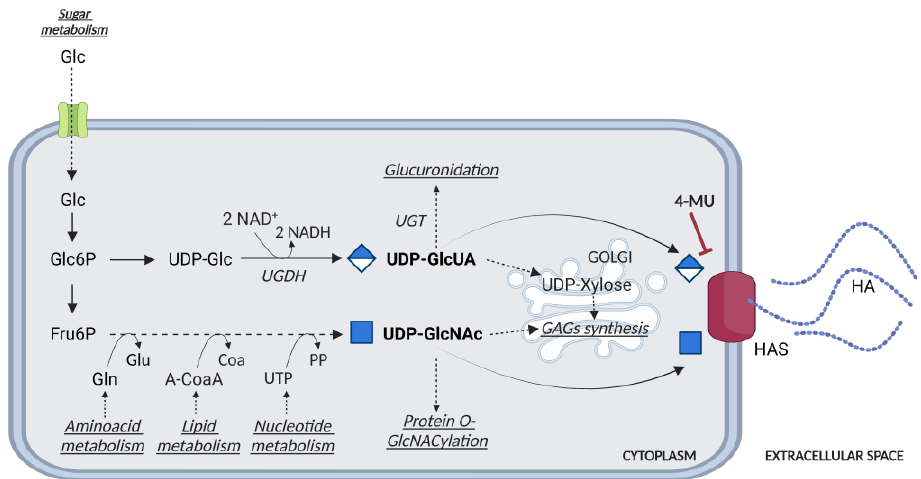
Figure 2. Schematic representation of the UDP-glucuronic acid (GlcUA) and UDP-N-acetylglucosamine (GlcNAc) biosynthetic pathways. Glucose (Glc) enters the cell through the GLUT transporters. Glucose 6-Phosphate (Glc6P) is transformed in UDP-glucose (UDP-Glc) and then in UDP-GlcUA. Fructose 6-phosphate (Fru6P) is directed to the synthesis of UDP-GlcNAc, by a complex metabolic way influenced by amino acids, lipids, and nucleotides availability. UDP-GlcUA and UDP-GlcNAc can be used for the synthesis of HA by HASes enzymes located at the plasma membrane, for glucuronidation and protein O-GlcNAcylation, respectively, or transported inside the ER/Golgi for the synthesis of GAGs and proteoglycans. 4-methylumbelliferone (4-MU) can act as a competitive inhibitor for HASes and decrease the UDP-GlcUA content.